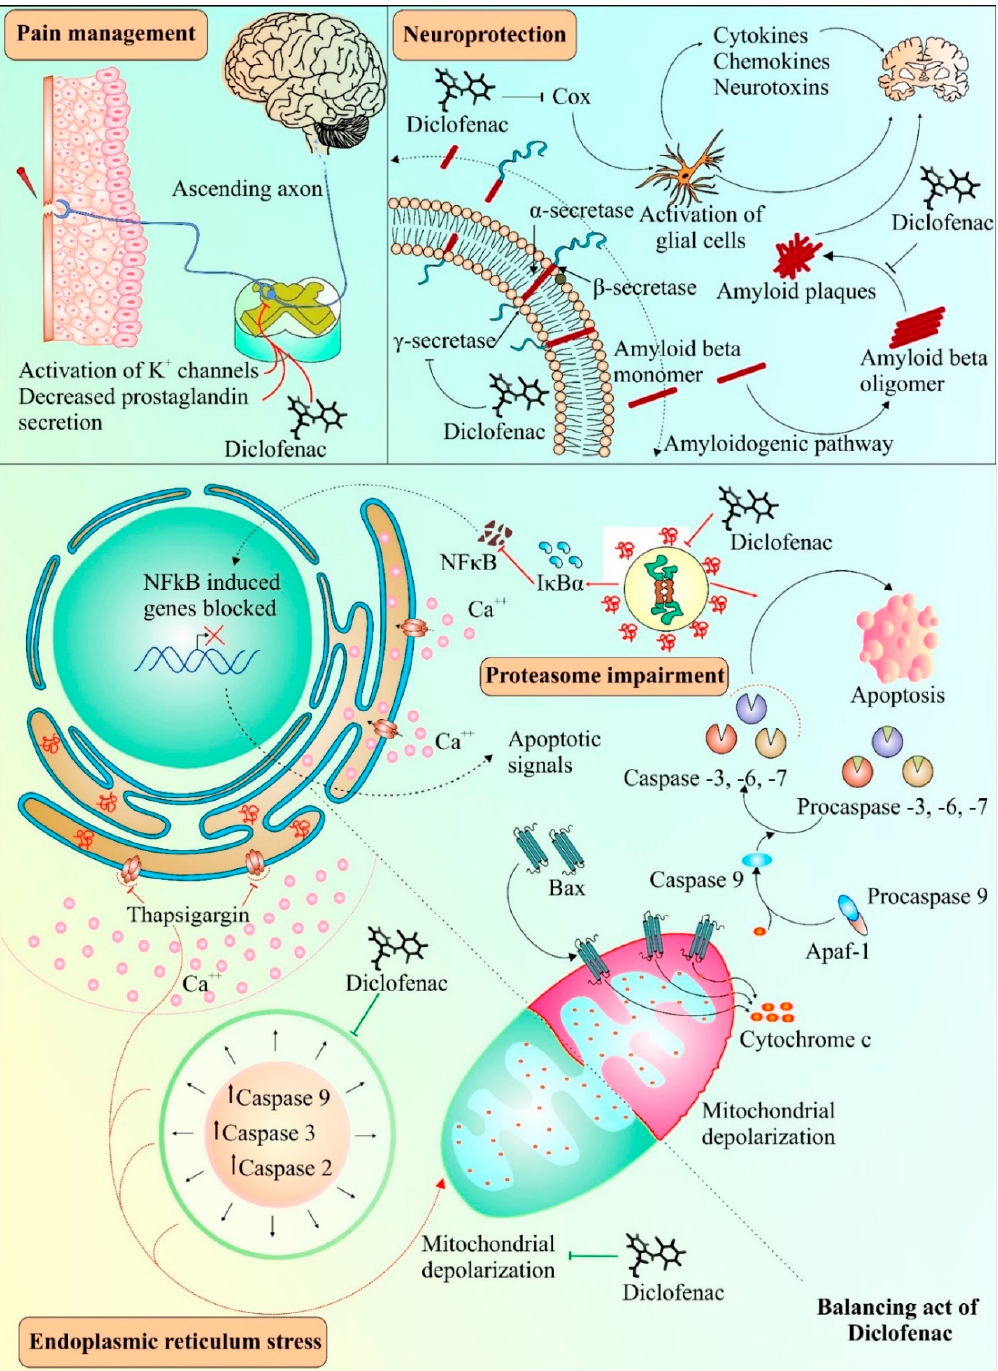
Figure 3. Possible and known applications of diclofenac. Diclofenac can act as an analgesic agent by activating transient outward potassium channels in neurons and simultaneously reducing the pro ‐ duction of prostaglandins. Diclofenac can also act as a potent inhibitor of oligomerization of β‐ am ‐ yloid fibrils and plaque formation, which can be used in the development of therapies for diseases involving amyloid aggregation. Alternatively, diclofenac also interferes with the activation of glial cells, which may further contribute to its neuroprotective properties. Diclofenac has both inhibitory and inducing effects on cell death under different conditions. Endoplasmic reticulum stress gener ‐ ated by thapsigargin leads to activation of caspases and causes mitochondrial depolarization. Di ‐ clofenac suppresses the intrinsic pathway of apoptosis by interfering with caspase activation and